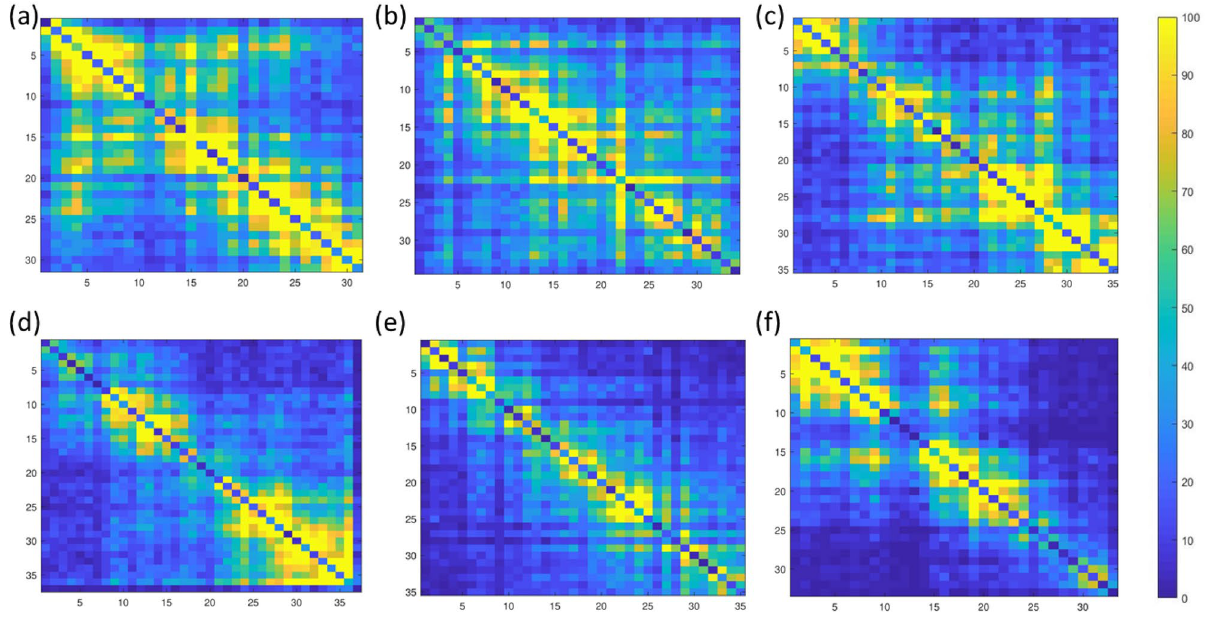
Figure 9. The illustration of six different TADs from Hi-C data of human ES (embryonic stem) chromosome 10. The contact frequency values are represented by colors. Bright yellow color indicate higher contact frequency, thus a short Eucledian distance between the two loci. As listed in Table 2, the AI values for TADs ( a – f ) are consistently decreasing, which is highly consistent with TAD patterns. We have also demonstrated six non-TADs in Fig. 10 and Table 3. It can be seen from the comparison that TADs tend to have more larger- contact values and their AI values are systematically larger than those from non-TADs.